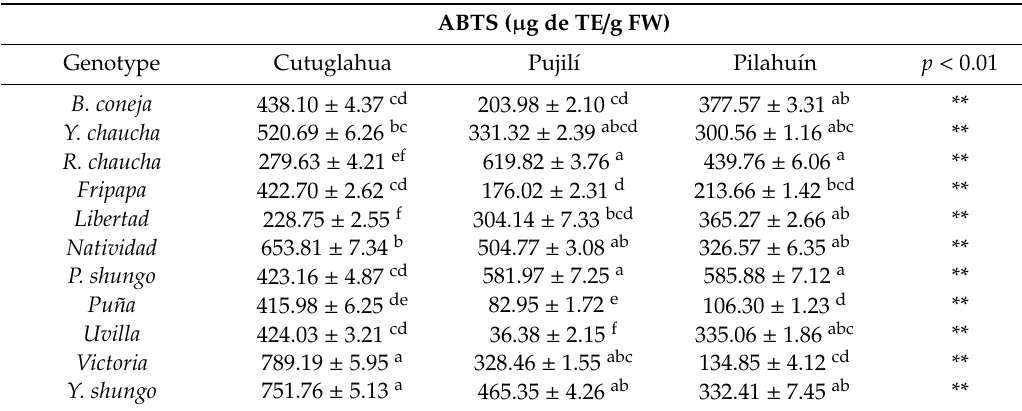
Table 2. Antioxidant capacity by ABTS method of 11 potato cultivars grown in Ecuador.